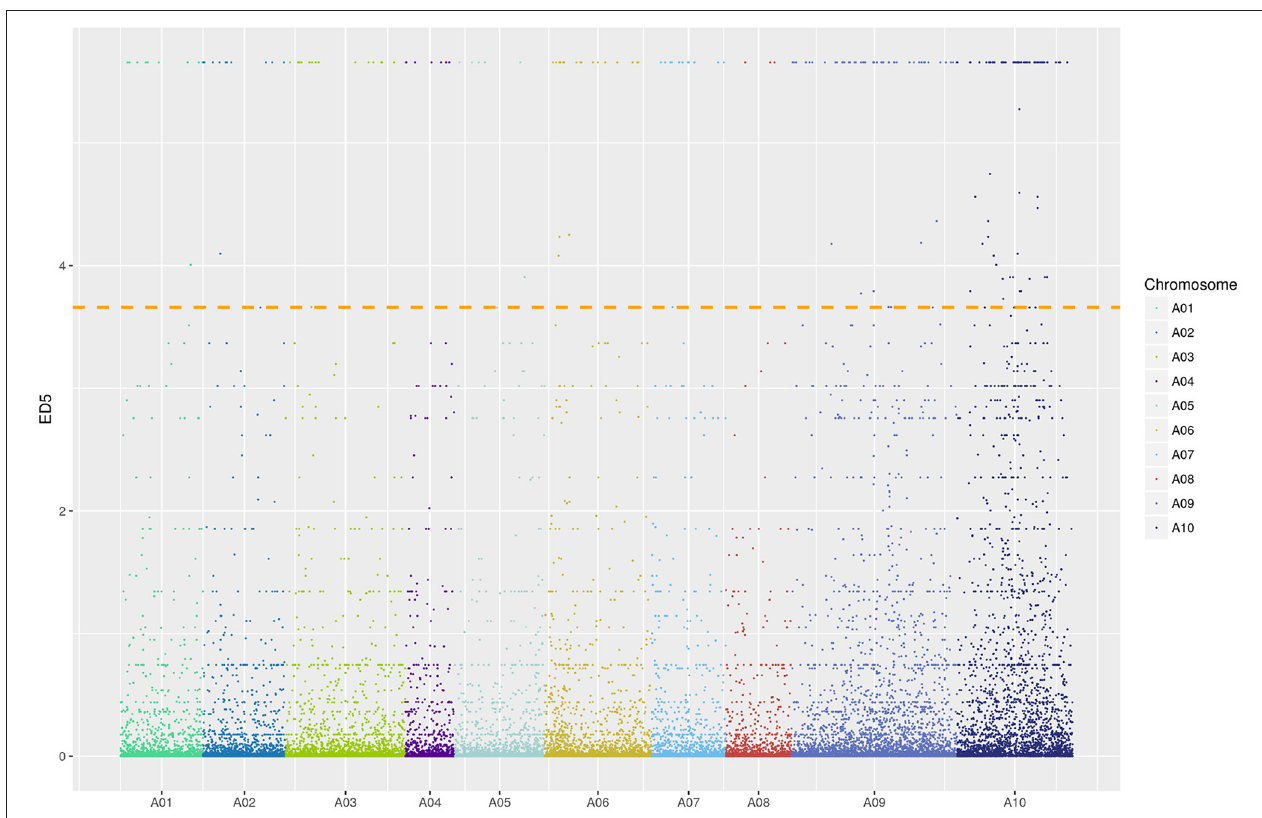
FIGURE 4 | Distribution of ED 5 values on chromosomes. Colors indicate various SNV sites on different chromosomes. Color width on X-axis represents the number of SNV sites in each chromosome; ordinate, ED 5 of each SNV locus; a dotted line, a correlation threshold of top 1% ED 5 value.